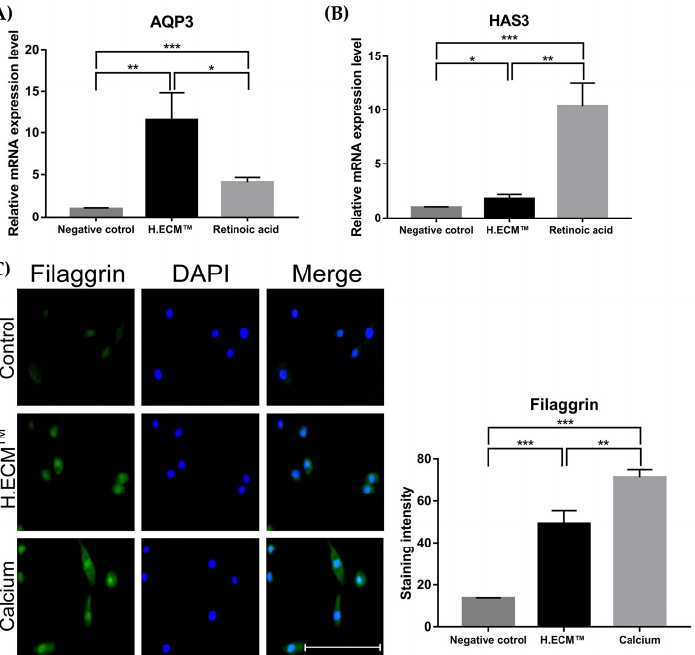
Figure 3. Expression levels of the AQP3 and HAS3 genes and the comparison of filaggrin expression via immunofluorescence staining using KCs. The expression of genes encoding skin hydration fac ‐ tors such as AQP3 ( A ) and HAS3 ( B ) were induced in the 0.05% H.ECM TM liposome treatment group more than in the negative control group; 1 μ M retinoic acid treatment was used as a positive control. Treatment with 0.05% H.ECM TM liposome induced filaggrin expression more significantly than the negative control ( C ) 1.8 mM calcium treatment was used as a positive control. Scale bar indicated 100 μ m. * p < 0.05, ** p < 0.01, *** p < 0.005.